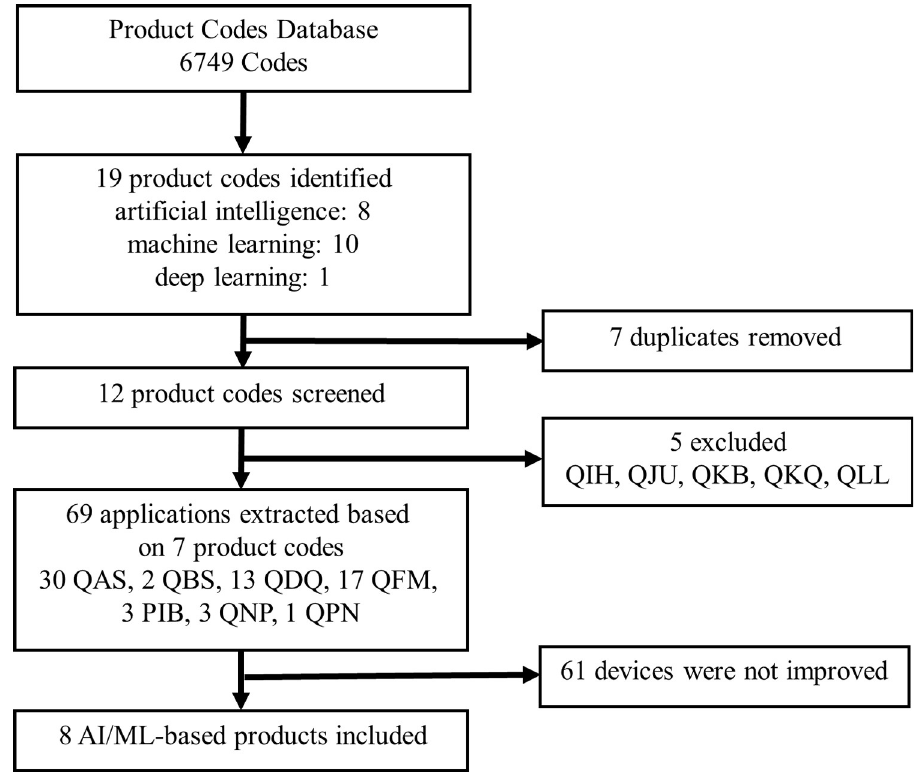
Fig 1. Flowchart for the extraction of AI/ML-based CAD devices with post-market improvements in the United States.